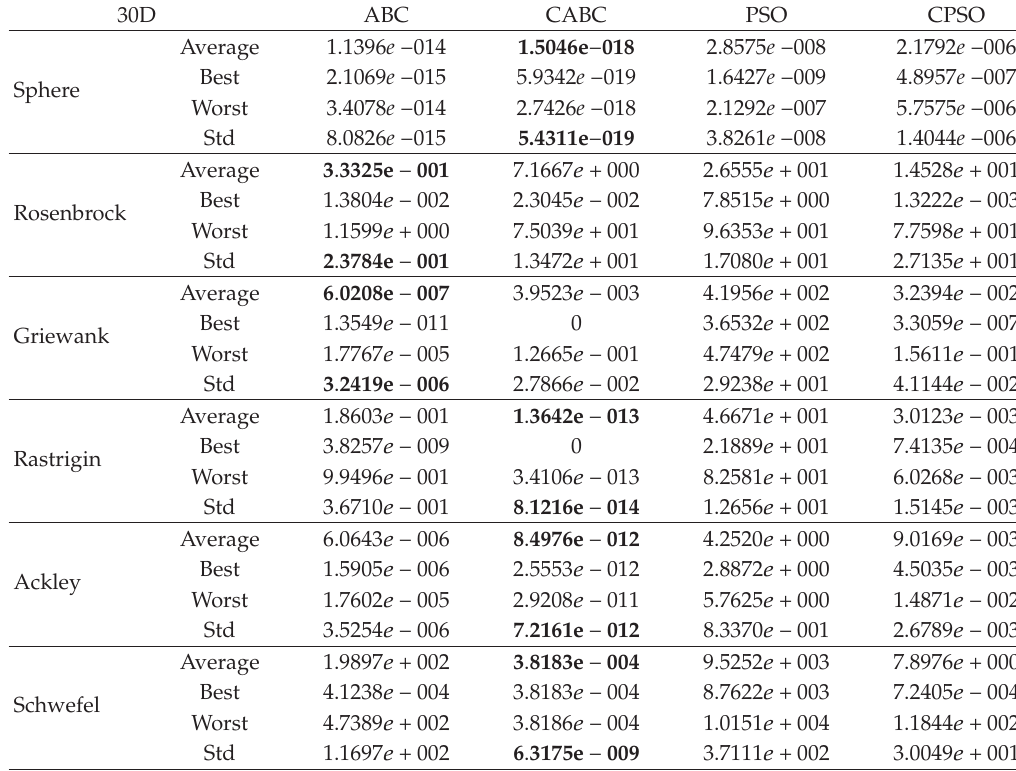
Table 1: Results comparison of di ff erent optimal algorithms for 30